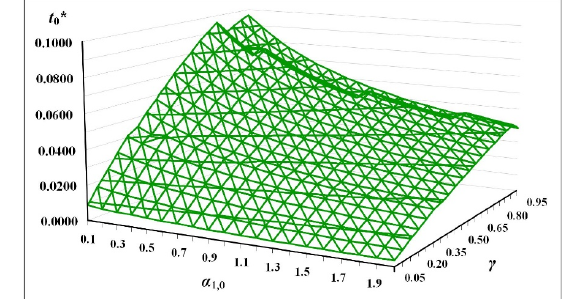
Fig. 7. Behavior of E [ TCU ( T A *, n *)] vis-à-vis the average ( C R, i / C i ) ratio and α 1,0